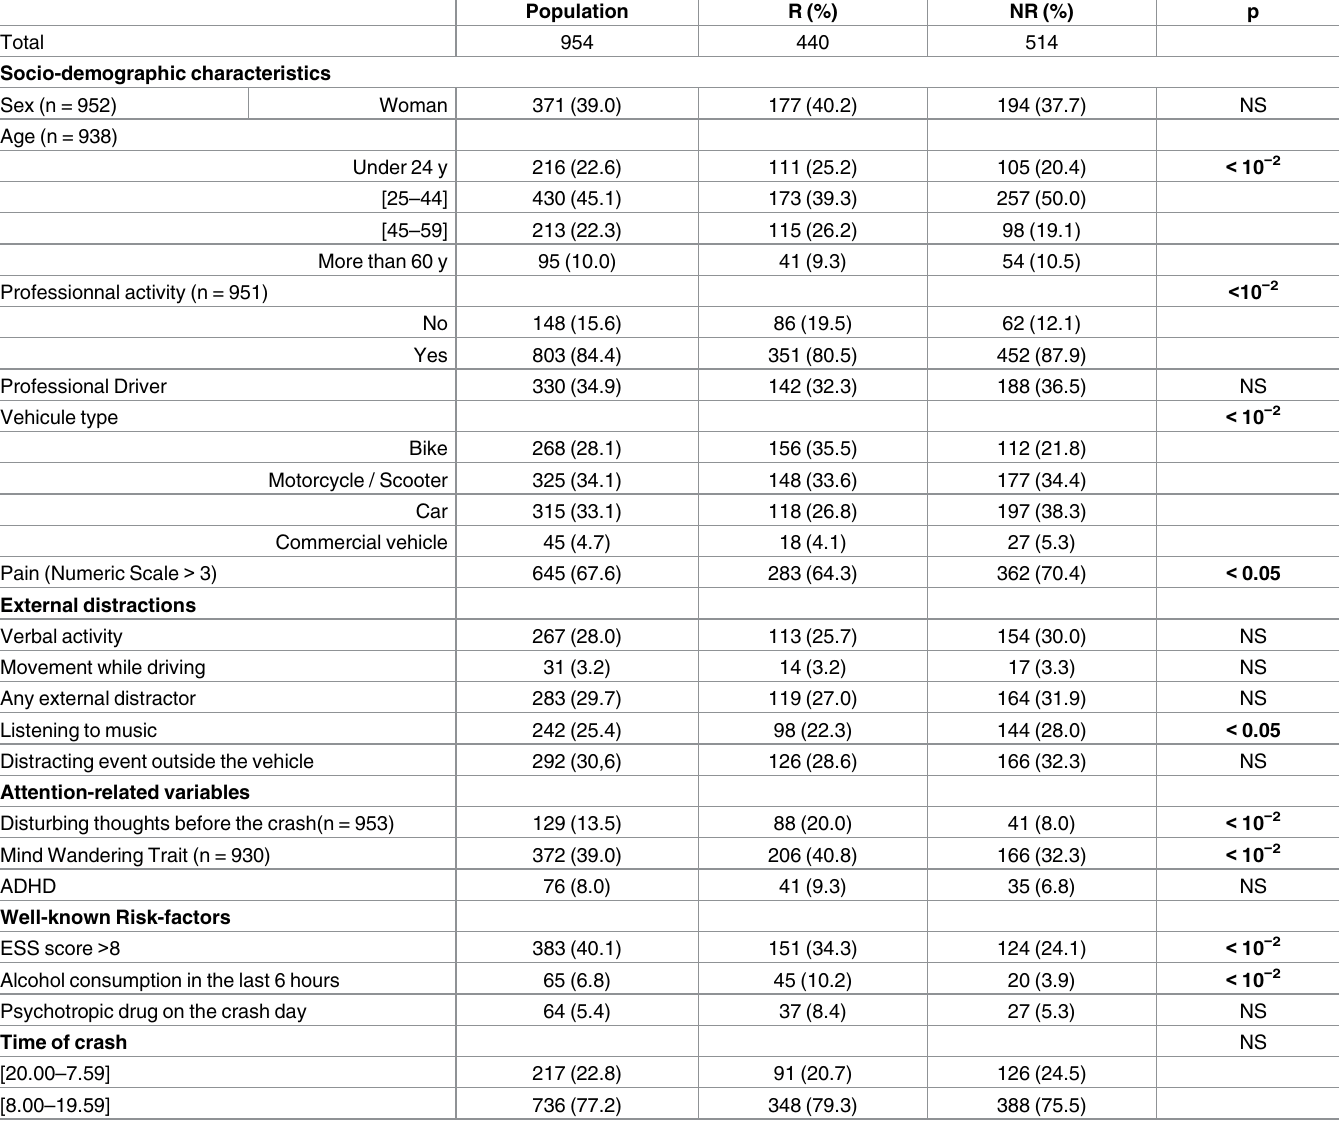
Table 1. Characteristics of the study population—Comparison between drivers responsible and not responsible for the road crash (n =